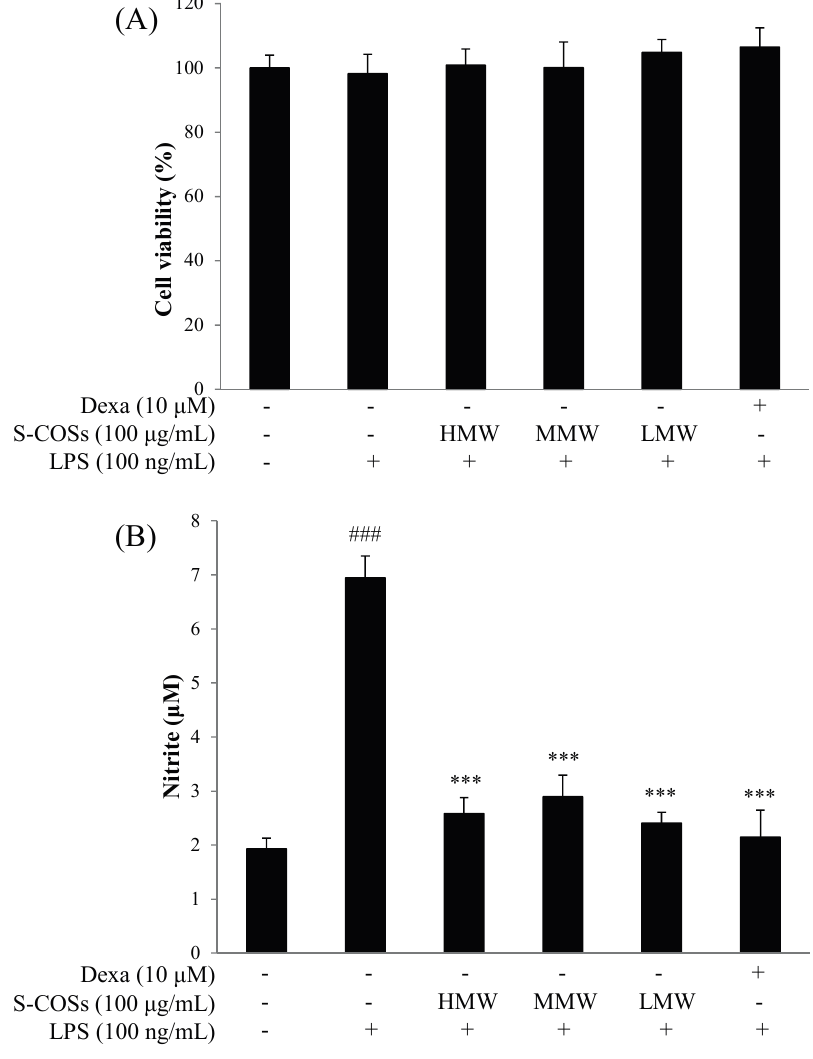
The cytotoxicity of sulfated chitosan oligosaccharides to RAW264.7 cells was measured by MTT assays. RAW264.7 macrophage cells were treated with sulfated chitosan oligosaccharides (S-HMWCOSs, S-MMWCOSs, S-LMWCOSs) at 100 μ g/mL for 24 h. As shown in Figure 2A, sulfated chitosan oligosaccharides are not cytotoxic in RAW264.7 cells at concentrations up to 100 μ g/mL. Figure 2. Cell viability ( A ) and nitrite production ( B ) of sulfated chitosan oligosaccharides (S-HMWCOSs, S-MMWCOSs and S-LMWCOSs) by LPS-stimulated RAW264.7 cells. RAW264.7 cells were treated with sulfated chitosan oligosaccharides (S-HMWCOSs, S-MMWCOSs and S-LMWCOSs) at 100 μ g/mL for 24 h. Cell viability was examined by MTT assays. The concentration of NO in the culture medium was determined by using the Griess assay. Results are expressed as mean ± SEM from three independent experiments. ### p < 0.001 versus control, *** p < 0.001 versus LPS alone group. Dexamethasone (Dexa) used as positive